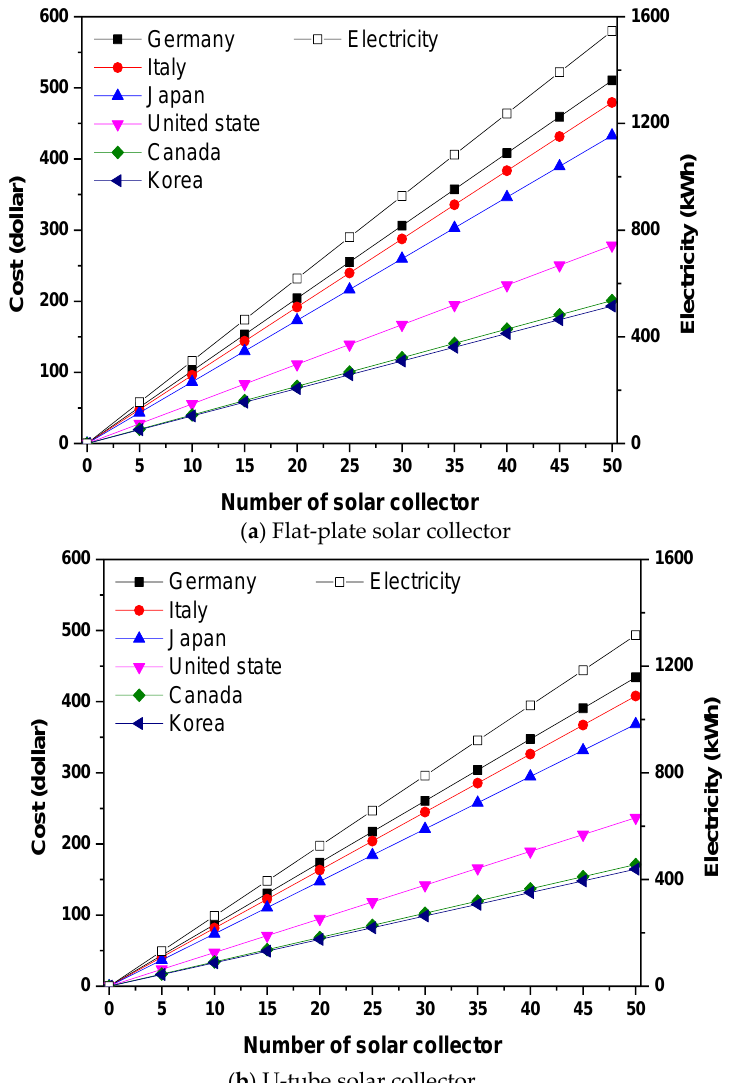
Figure 6. Electricity and electricity cost saving depending on the number of solar collectors (Al 2 O 3 size: 20 nm, Concentration: 1.0 vol %): ( a ) Flat-plate solar collector; ( b ) U-tube solar collector.